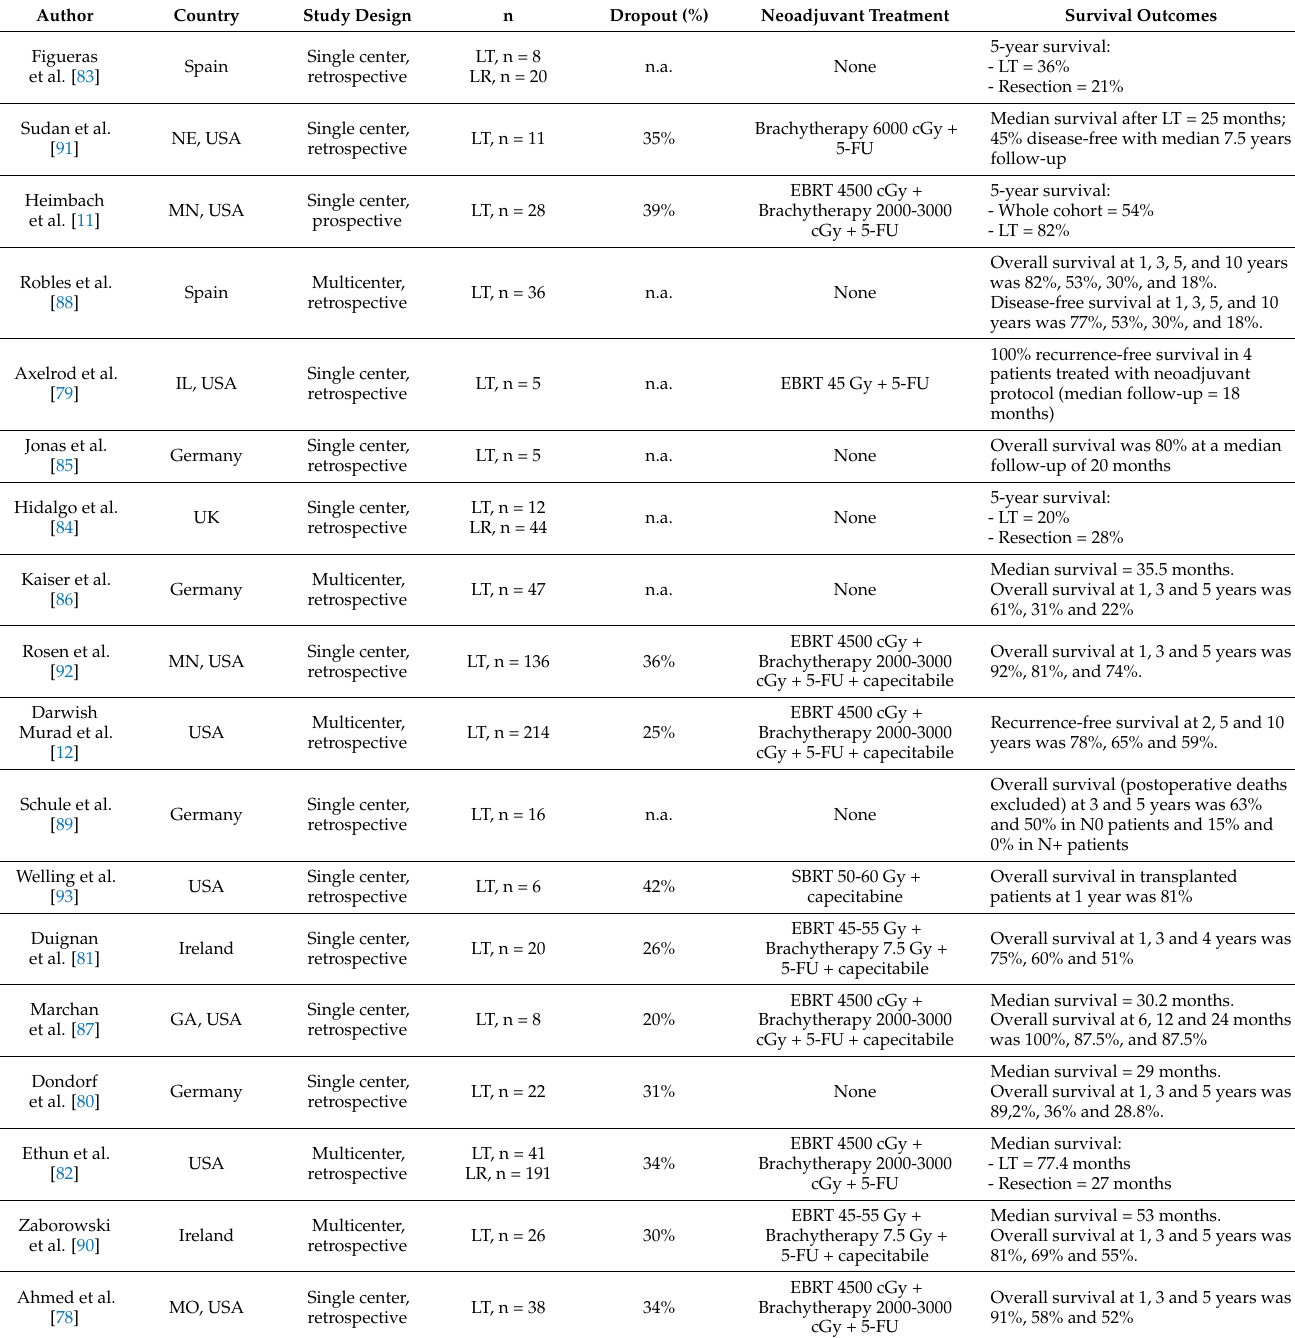
Table 1. Results of LT for